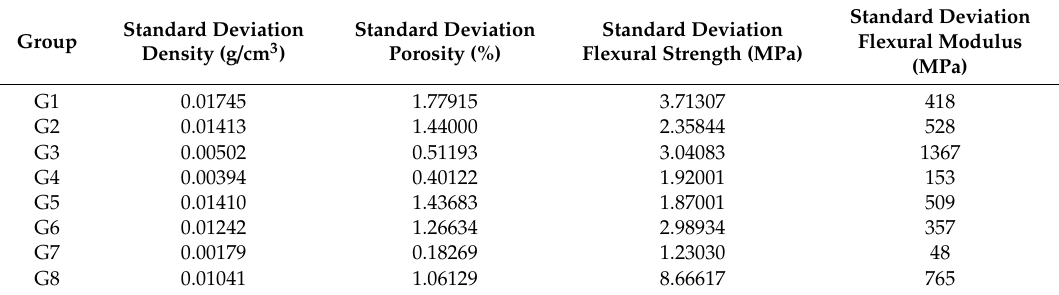
Figure 9. Average flexural modulus for all the series. Table 2. Standard deviations for all